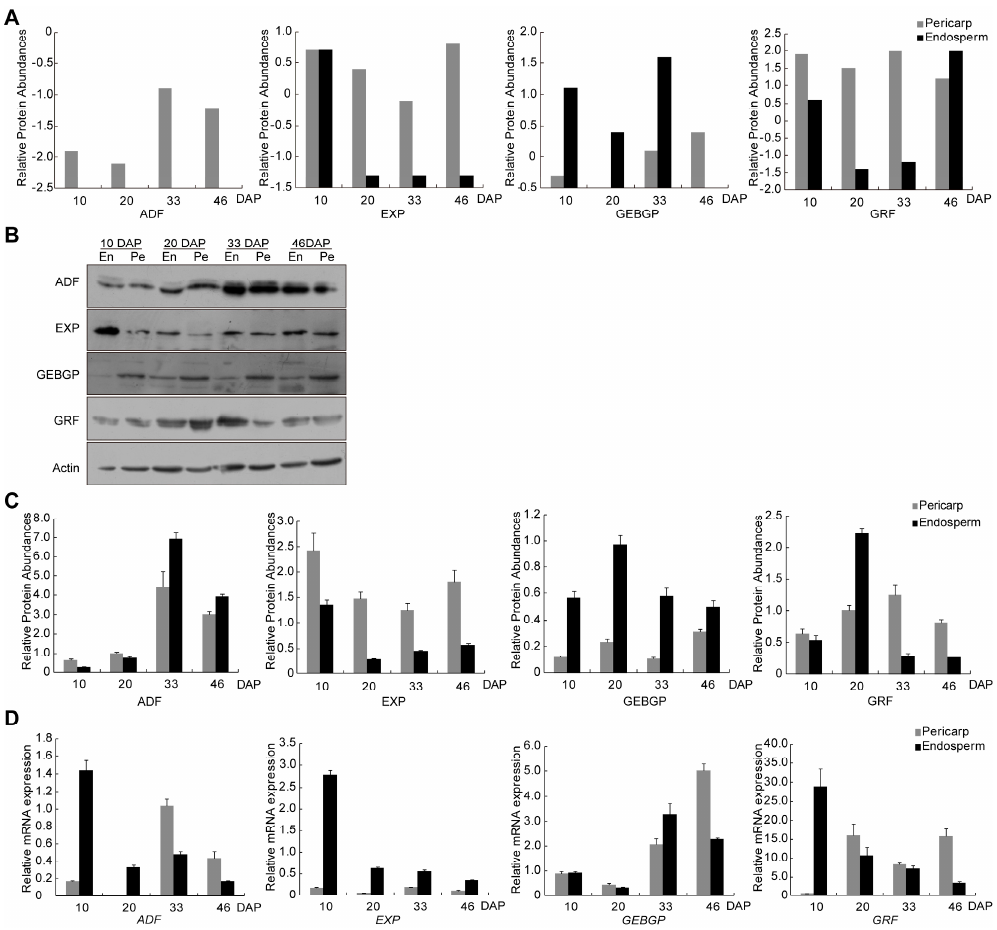
Figure 6. Real-time qPCR and Western blot analysis for the four proteins from iTRAQ. ( A ) Relative abundance of the protein from iTRAQ; ( B ) Accumulation of different proteins: ADF (actin-depolymerizing factor), EXP (exoglucanase1 precursor), GEBGP (glucan endo-1,3- β -glucosidase precursor), GRF (general regulatory factor) and Actin was analyzed by western-blot using specific antibodies; ( C ) Western blot analysis for the proteins after separation on SDS-PAGE using actin as the control; and ( D ) Real-time qPCR for the four proteins at mRNA expression at 10, 20, 33 and 46 DAP. The results are presented as means ± SEM pooled from three independent experiments in ( C , D ).